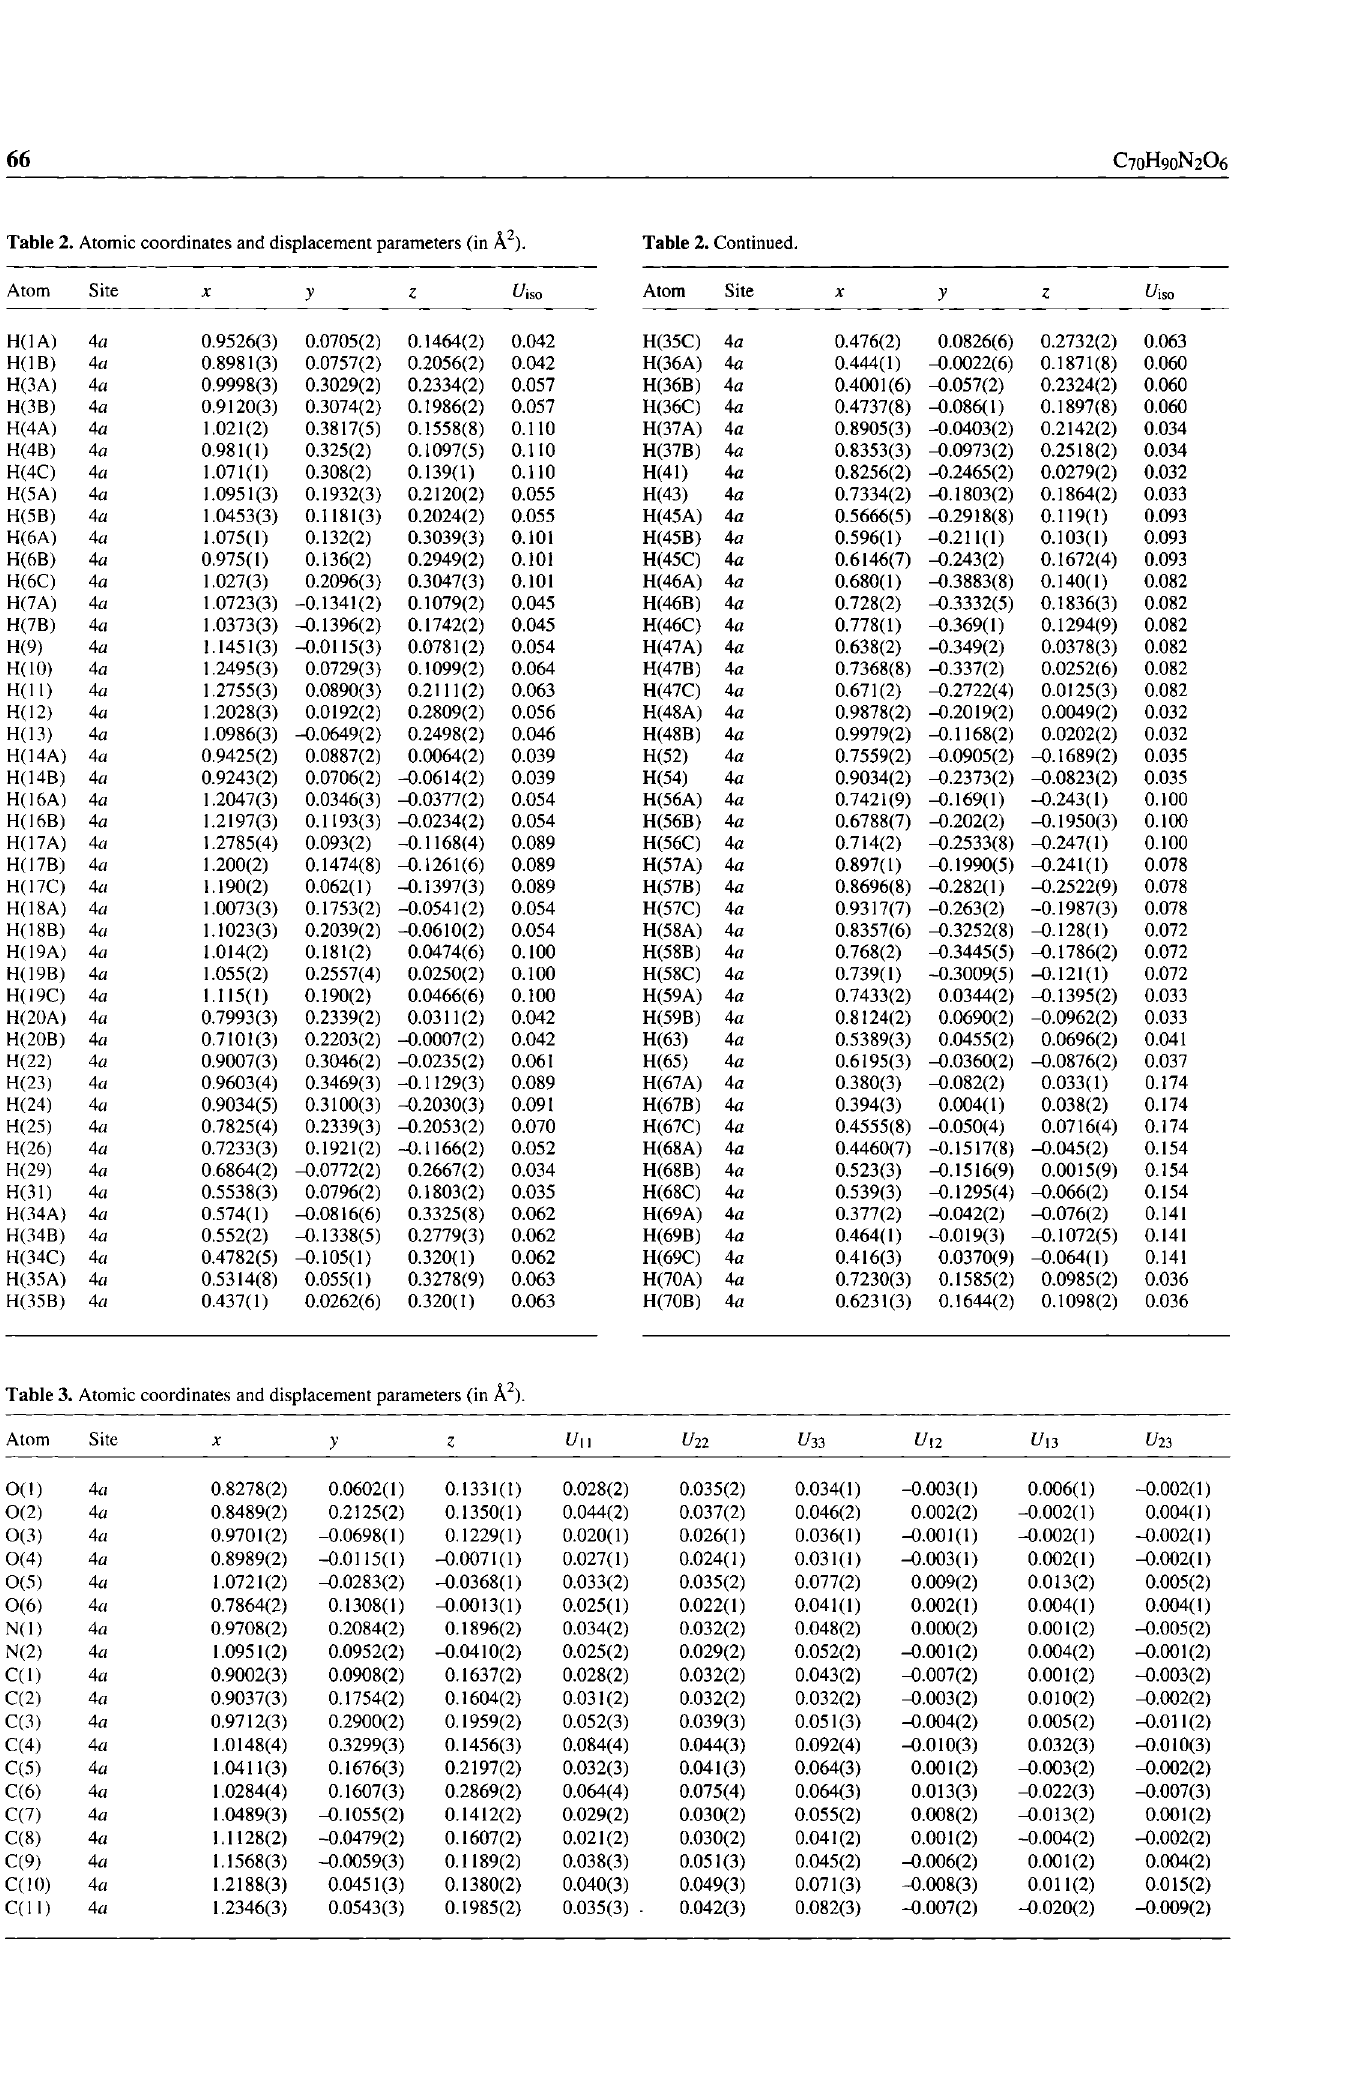
Table 3. Atomic coordinates and displacement parameters (in Ä 2